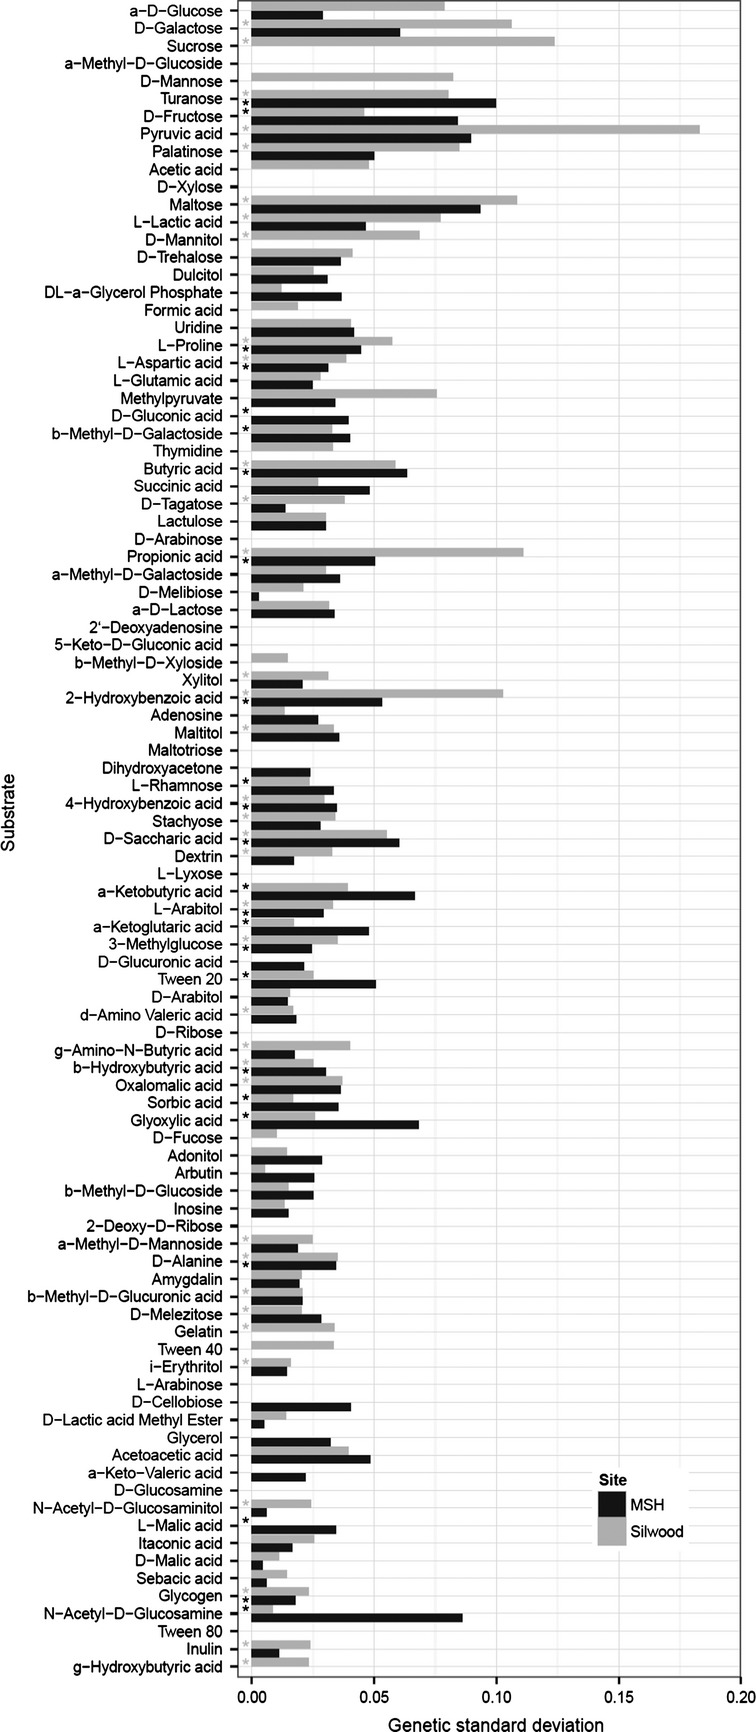
Variance of growth among substrates. The histogram bar indicates the square root of the among-isolates variance component (“genetic standard deviation”) for 72 h scores in the MSH (black) and Silwood (gray) surveys. Substrates are in the same order as in Figure1. Asterisk denotes testwise significance at P < 0.001 (experiment-wise P < 0.1).